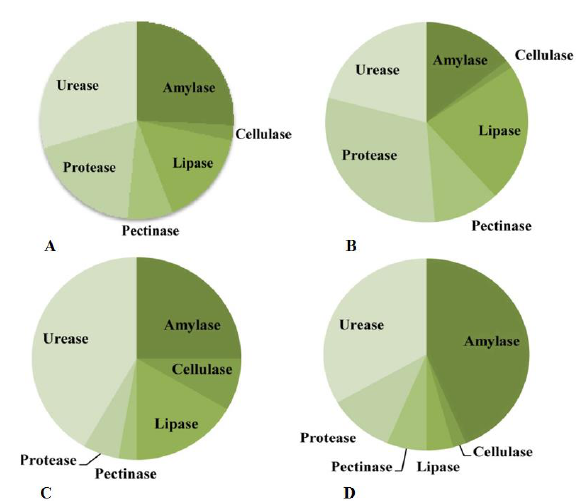
Fig. 6. Enzyme production frequency among halophilic strains obtained from Tis solar saltern. A: the overall enzyme production rate; B, C, and D: rate of enzymes with the weak, medium, and strong activities,